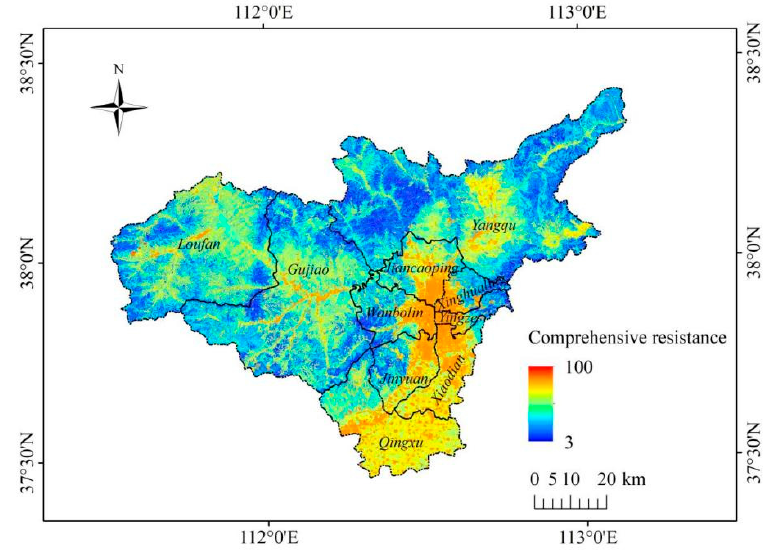
Figure 8. Comprehensive resistance surface constructions.